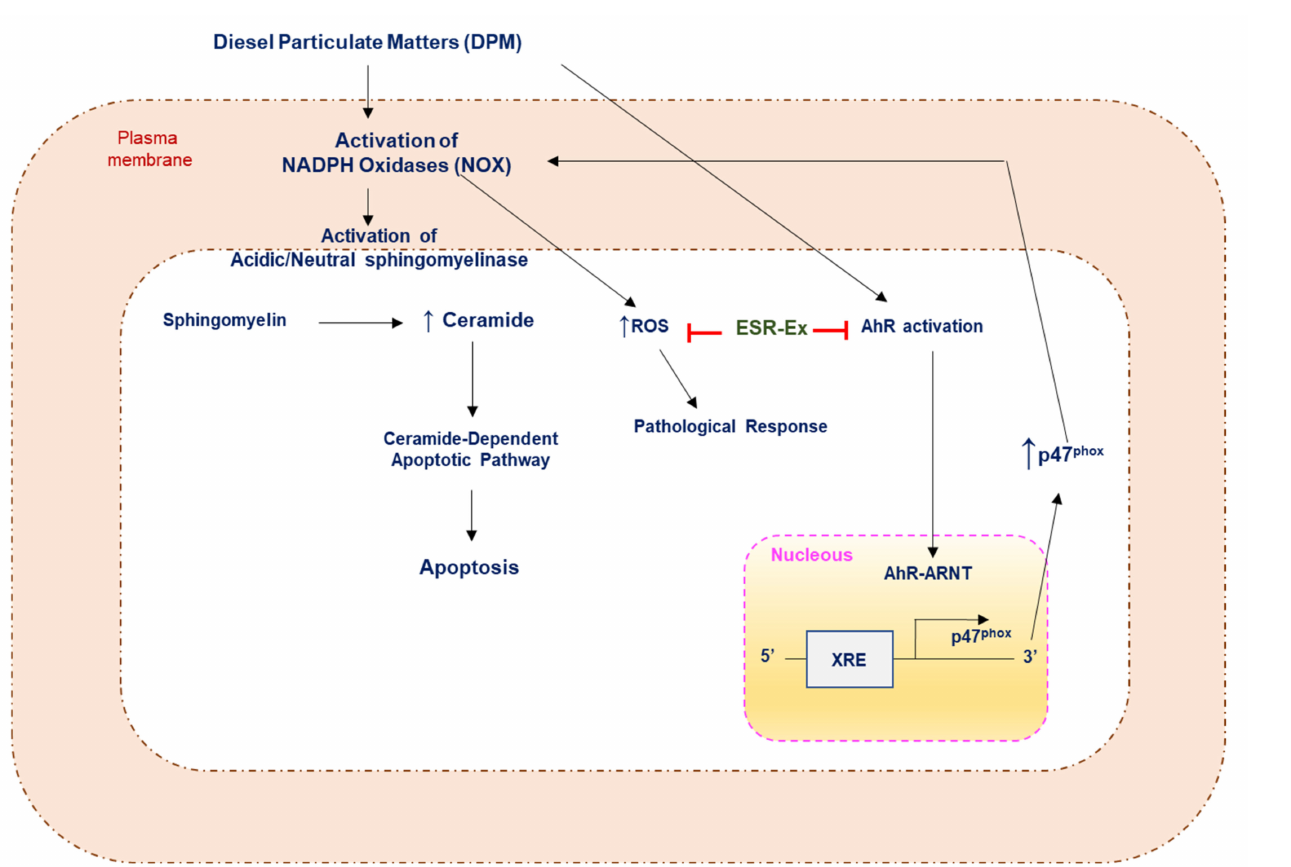
Figure 9. Proposed mechanism of ESR-Ex intervention in DPM-mediated ceramide-induced